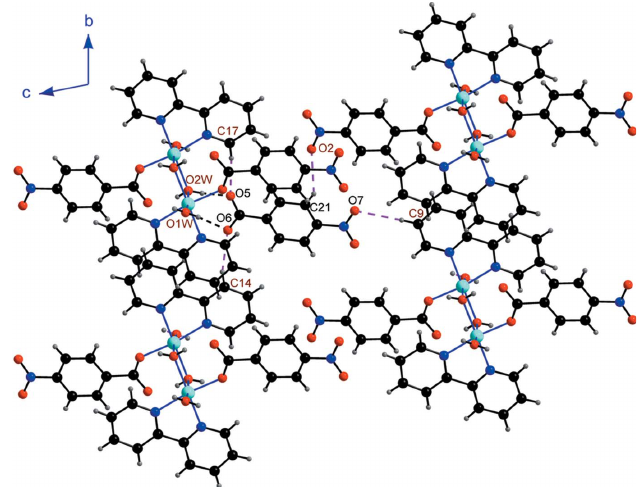
Figure 3 Environment of the anion, showing its hydrogen bonds to four